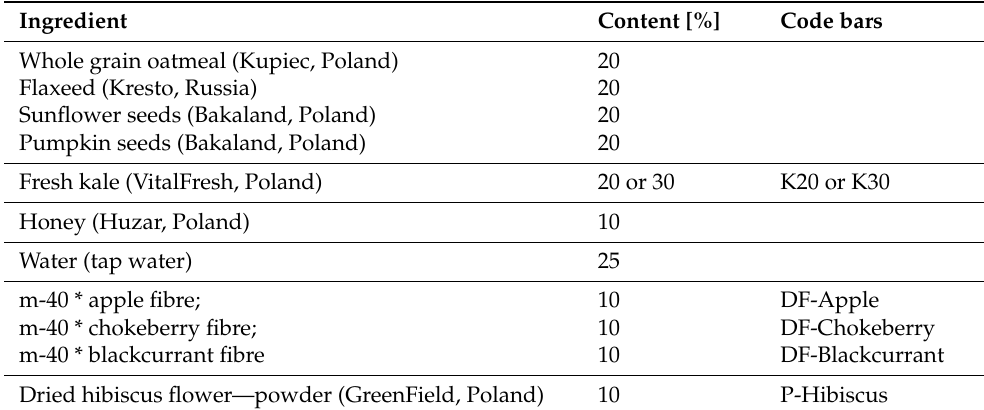
* Coarse fibre, particle size approx. 40 µ